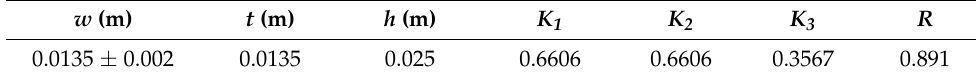
Table 1. Characteristic dimensions and shape